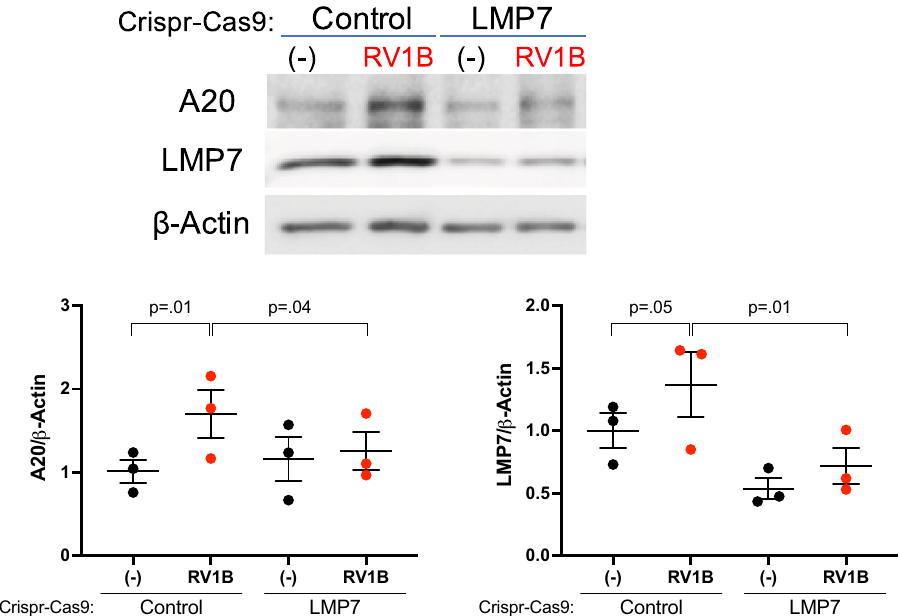
Figure 6. LMP7 promotes A20 expression following RV infection . HTBE cells (n = 3 independent experiments) were transduced with lentivirus containing the LMP7 sgRNA or scrambled control (Control) plasmid construct and were differentiated at air–liquid interface (ALI) culture. Cells were infected with 10 5 PFU/ well RV1B or 0.1% BSA-PBS (−) at day 21 of ALI. Representative western blot image and densitometry of A20 protein (90 kDa). Data were analyzed using one-way ANOVA with Holm–Sidak’s